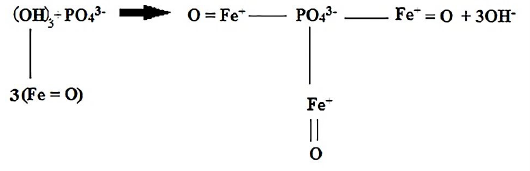
Figure 1. Mechanism of phosphorus occurrence in